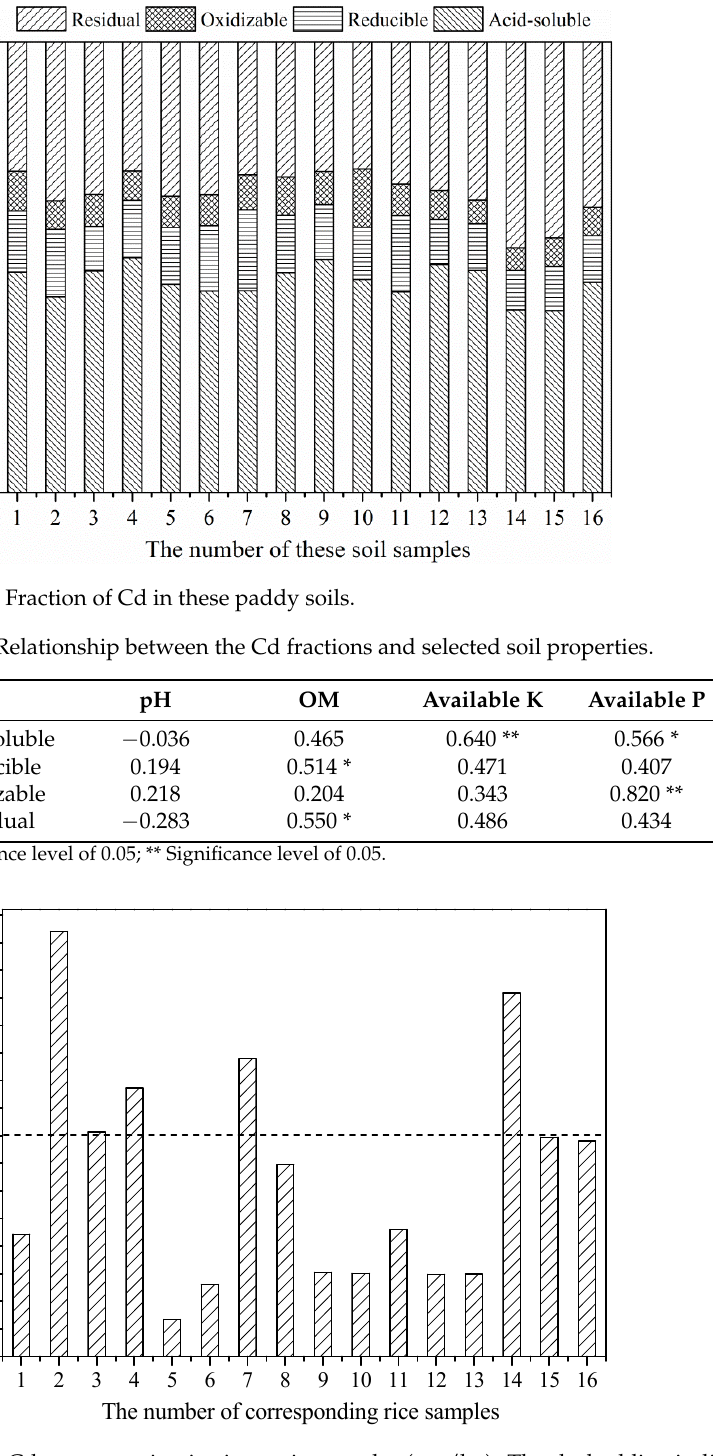
Figure 5. Cd concentration in rice grain samples (mg/kg). The dashed line indicates the national standard limits of China (GB 2762 ‐